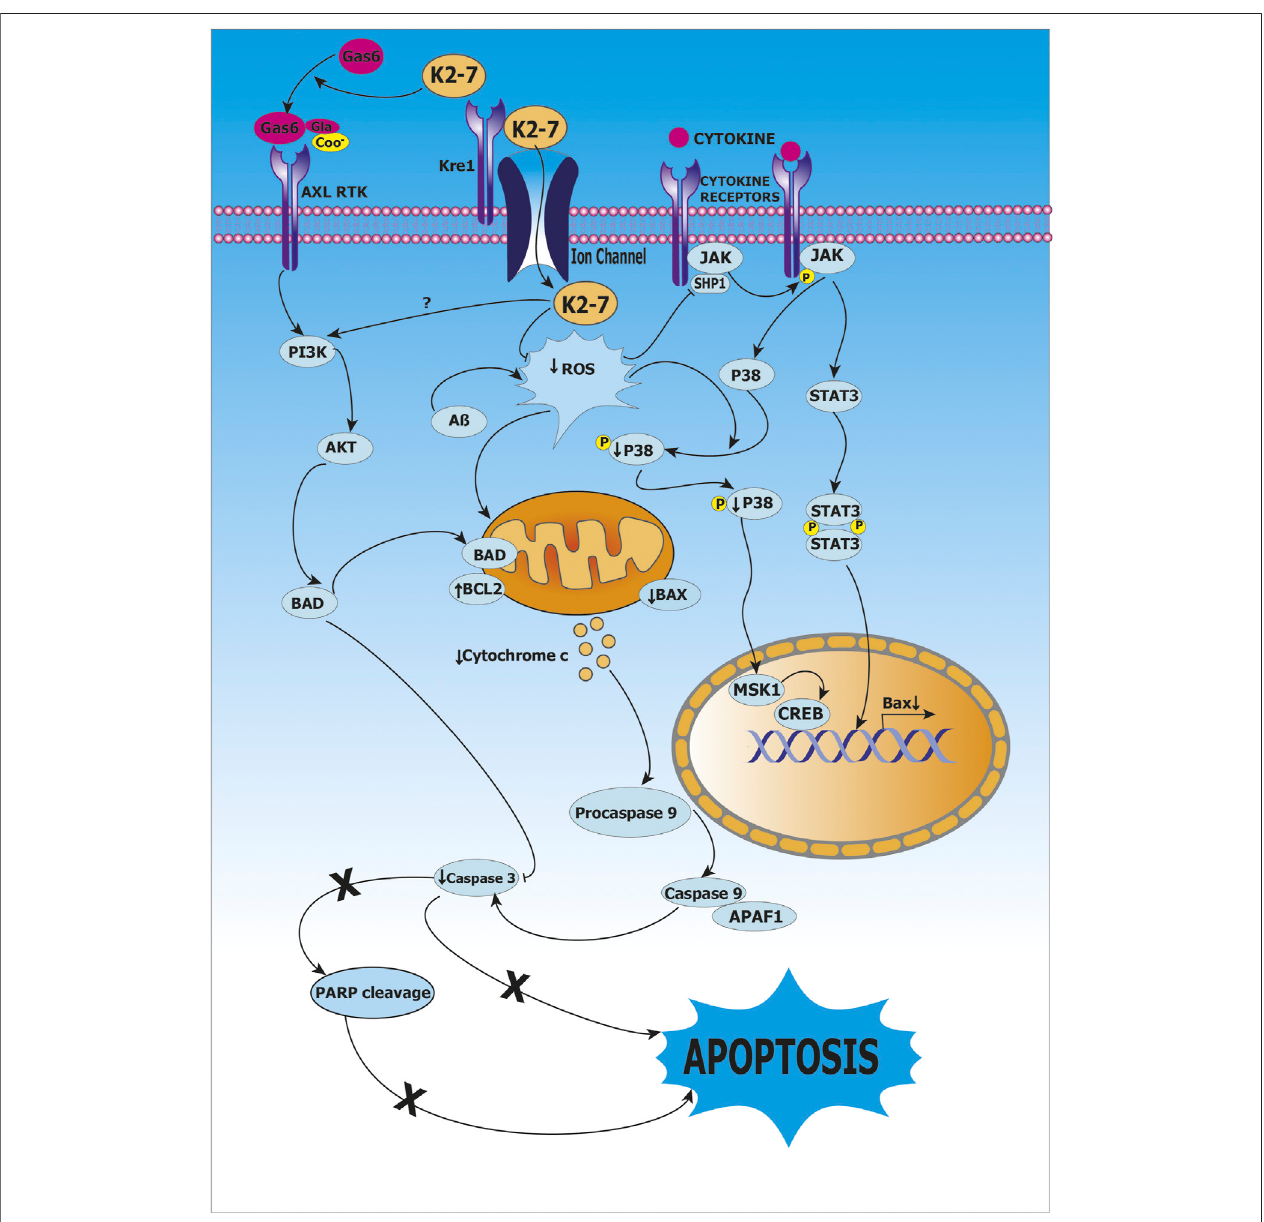
FIGURE5| RoleofvitaminK2-7inAlzheimer ’ sdisease.VitaminK2-7facilitatescarboxylationofglutamate(Glu)residuepresentongrowtharrest-speci fi cprotein6 (Gas6) to γ -carboxyglutamate (Gla) leading to its activation, activated Gas6 binds to AXL receptor tyrosine kinase (AXL RTK) and initiates phosphoinositide 3-kinase/ protein kinase B/BCL-2-associated death promoter protein (PI3K/AKT/BAD) signaling, BAD has an inhibitory effect on Caspase 3, this abrogates apoptosis and provides protection by K2-7 against β -amyloid (A β )-induced cytotoxicity. In cytosol, reactive oxygen species (ROS) activates Janus kinase-Signal transducer and activator of transcription protein (JAK-STAT) pathway resulting in transcription of BCL-2-associated X protein (BAX), BAX causes release of cytochrome c from mitochondria, cytochrome c leads to activation of Caspase 3 that results in apoptosis; vitamin K2-7 abrogates apoptosis by inhibiting Caspase 3.